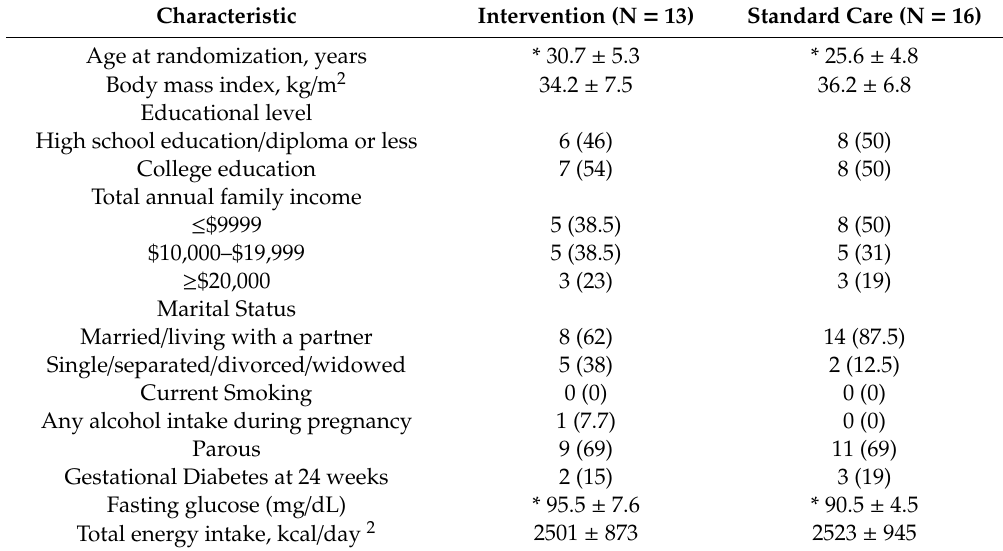
Table 1. Characteristics of PEARLS participants during early pregnancy in the current study stratified by intervention arm, N = 29 1